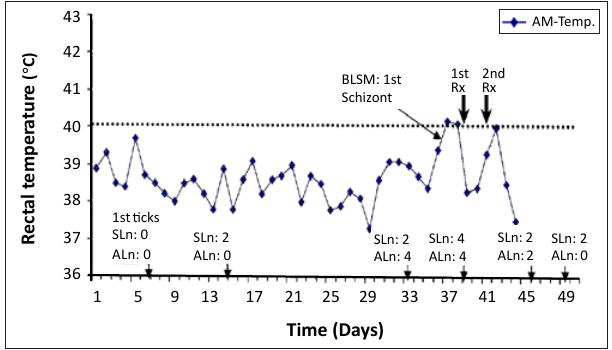
FIGURE 2: Animal 218: Blood smear findings, lymph node findings and day of treatment in relation to rectal temperature over